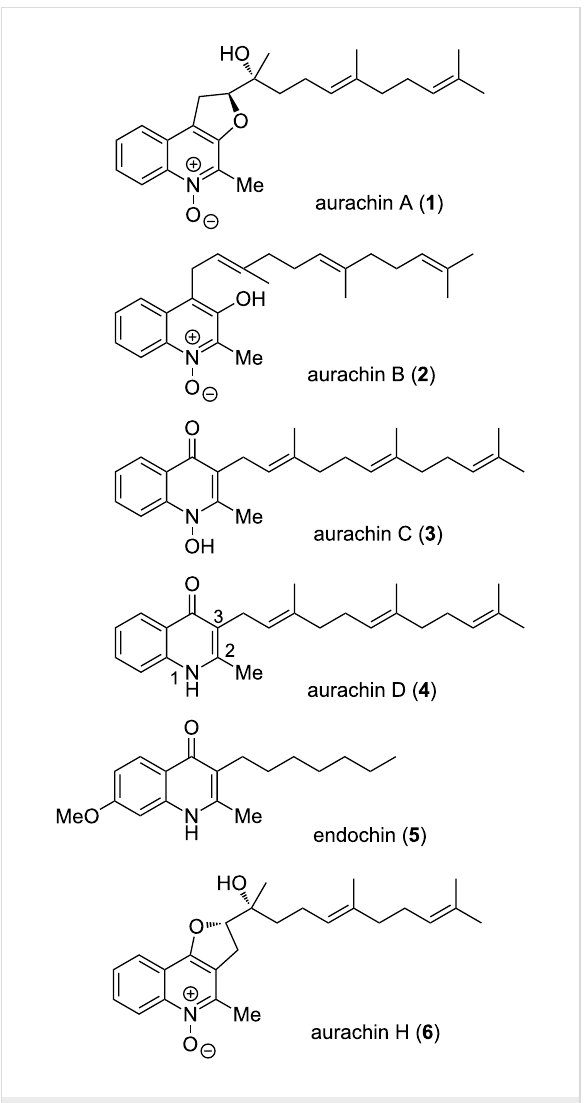
Figure 1: The 2-methyl-4(1 H )-quinolone compounds: aurachins and endochin.